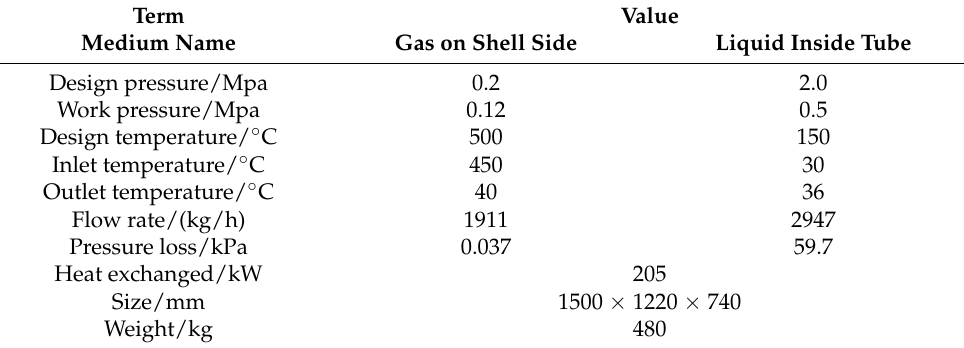
Table 2. Operation parameters of exhaust gas cooler.